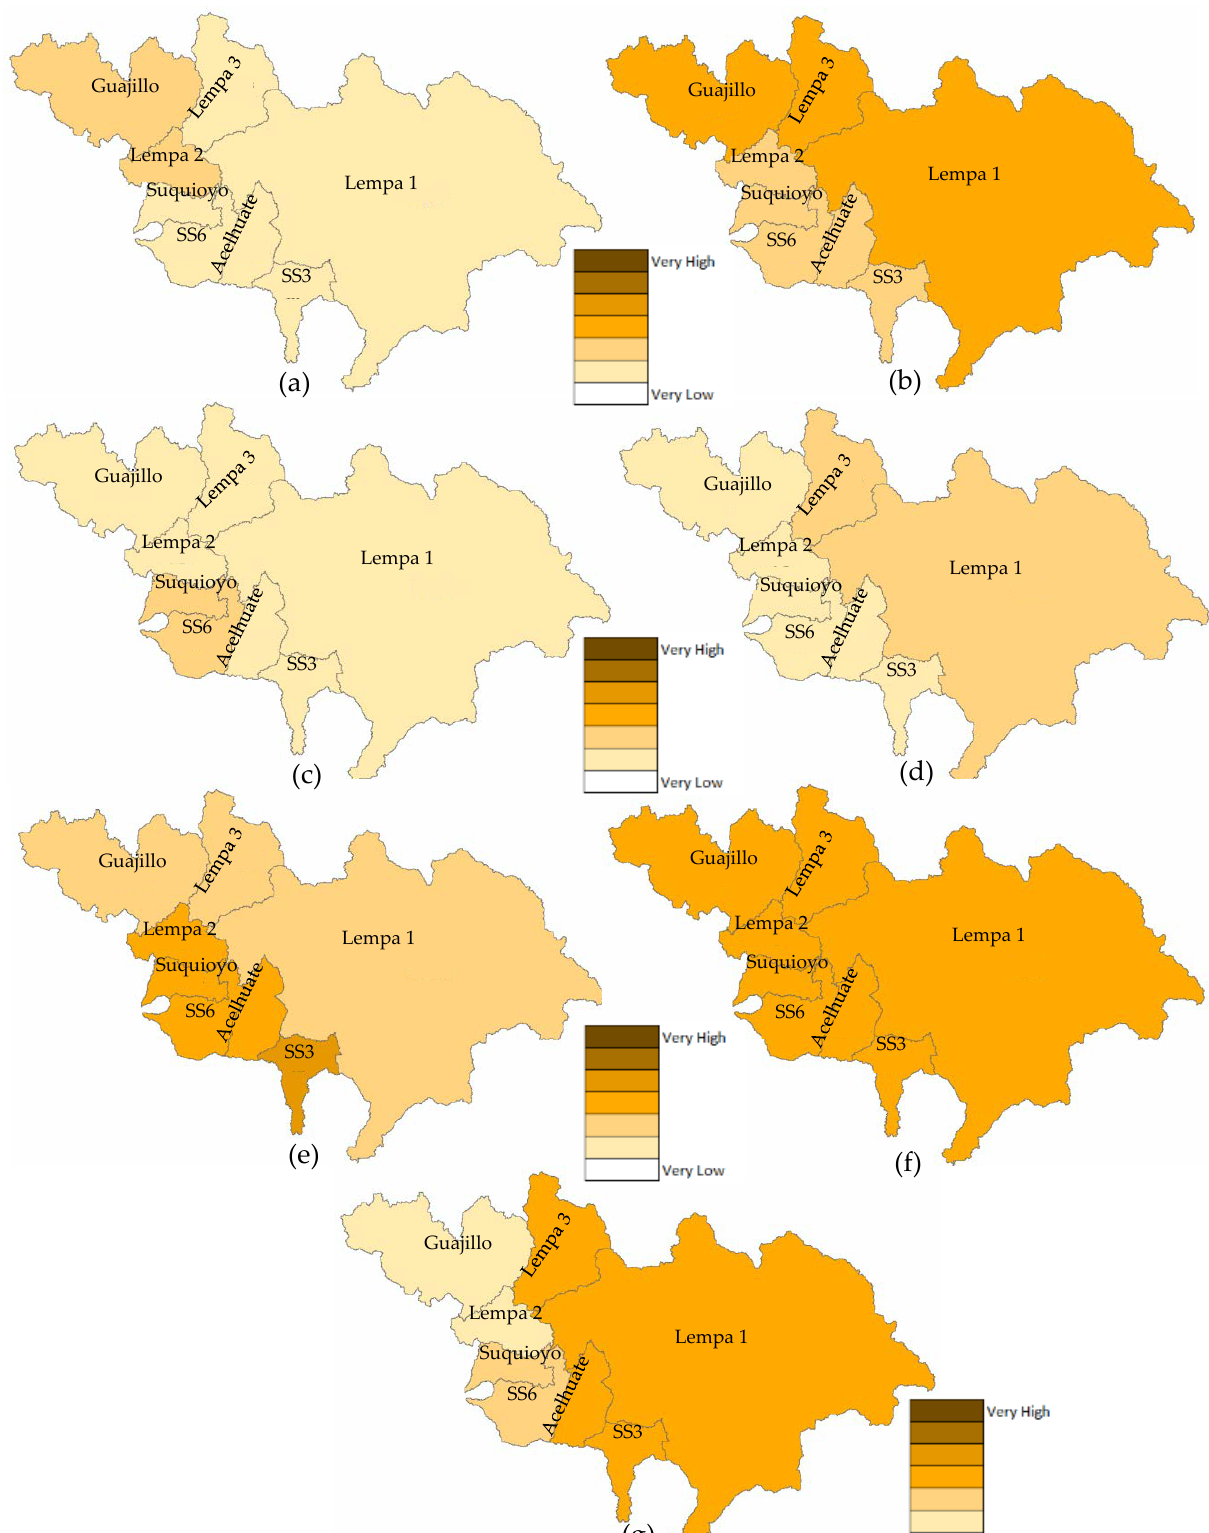
Figure 7. Drought Intensity ( D I ) maps based on SEDI06 in eight sub-basins of Lempa River basin. Considering six quin- quennials, and the overall period: ( a ) 1981 to 1985; ( b ) 1986 to 1990; ( c ) 1991 to 1995; ( d ) 1996 to 2000; ( e ) 2001 to 2005; ( f ) 2006 to 2010; ( g ) 1980 to 2010 (31